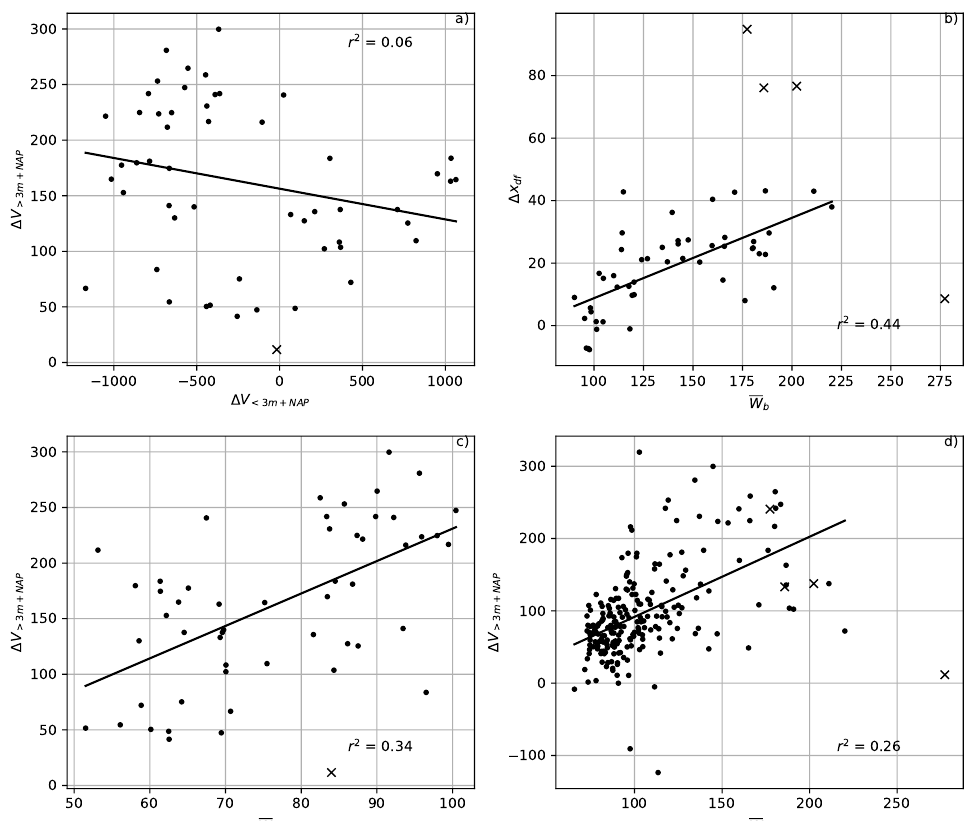
Figure 15. Correlations of beach width and volume changes. ( a ) Correlation of volume change below 3 m + NAP and volume change above 3 m + NAP; ( b ) average beach width and dune foot position change; ( c ) average intertidal beach width and volume change above 3 m + NAP at the Hondsbossche Dunes; and ( d ) average beach width and volume change above 3 m + NAP at the NNH coast for the period between April 2015 and 2020. All values are based on the JARKUS dataset only. Observations marked with a cross are treated as outliers in the determination of the correlation coefficient. At these locations, dune foot changes are dominated by an alongshore infilling of a local stepback in the dune front at the edge of the original sea dike (Figure 11a,d km 20–20.5) or beach width and dune volume cannot be determined appropriately according to our definition due to a local opening in the dune in front of the lagoon (Figure 11e km